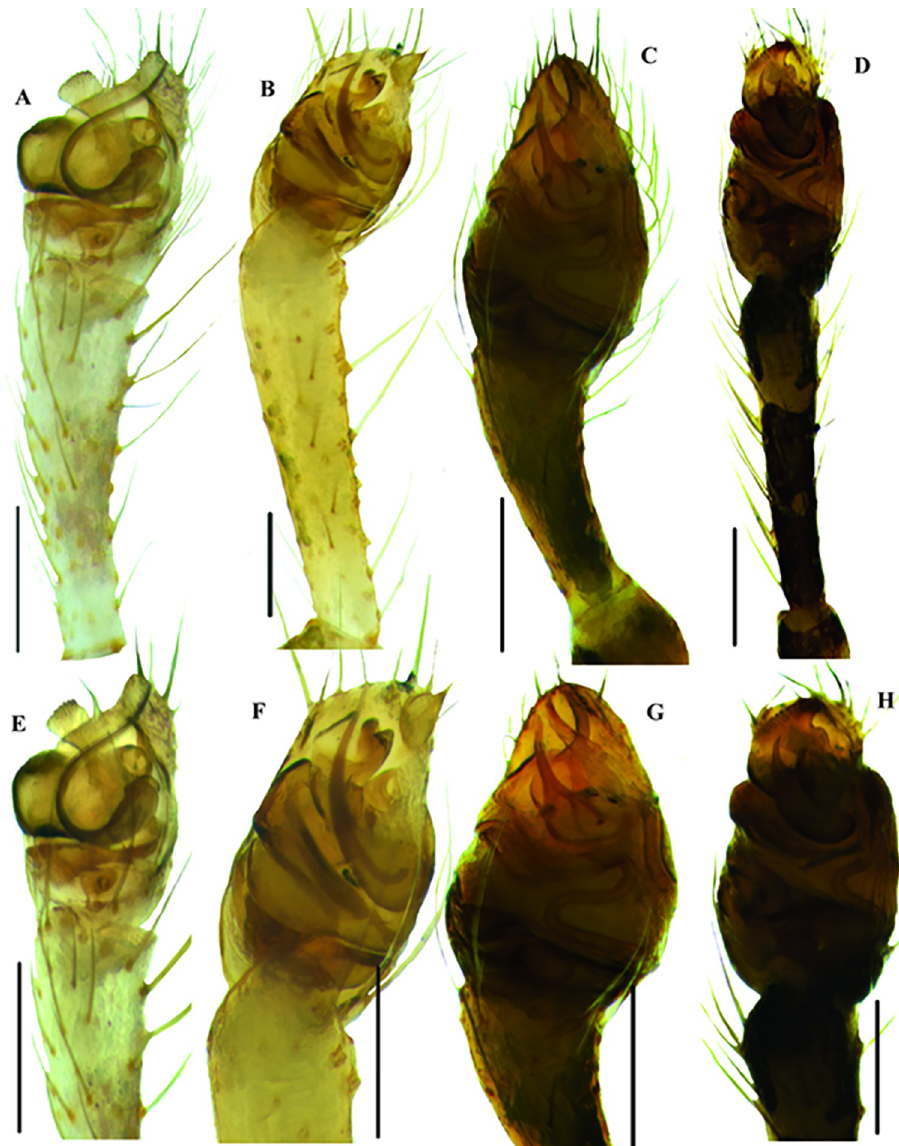
Fig 5. Male palpal morphology of Rhomphaea species of Sri Lanka. A–H male palps of Rhomphaea species, ventral view. A–B, R . shanthi sp. nov.; C–D, R . jacko sp. nov.; E–F, R . martini sp. nov., G–H, R . marani sp. nov. Scale bars = 0.2 mm